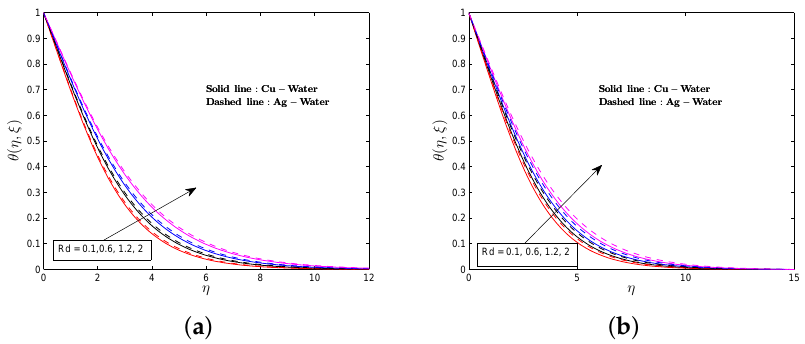
Figure 11. Temperature profiles for various values Rd . ( a ) vertical plate; ( b ) horizontal plate.